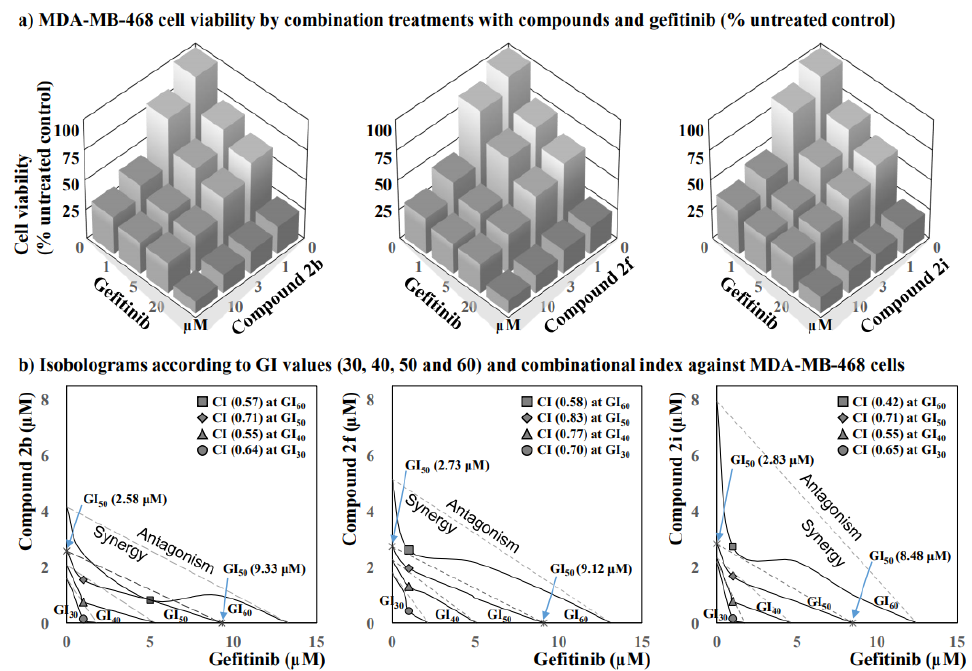
Figure 3. Combinational treatment with gefitinib and compounds ( 2b , 2f and 2i ), and their isobolo- grams. ( a ) MDA-MB-468 cell viability by combination treatments with compounds and gefitinib (% untreated control); ( b ) isobolograms according to GI values (30, 40, 50 and 60) and combinational index against MDA-MB-468 cells.